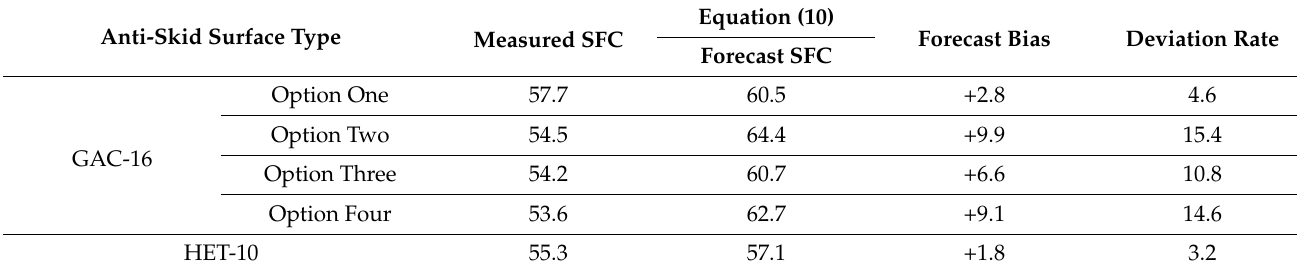
Table 11. Comparison of predicted value and measured value.